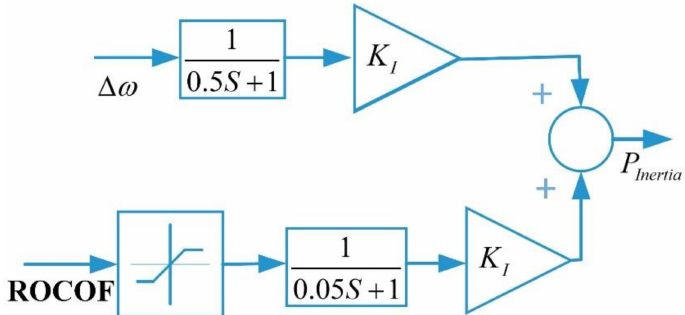
Figure 5. The required inertial power calculation block.